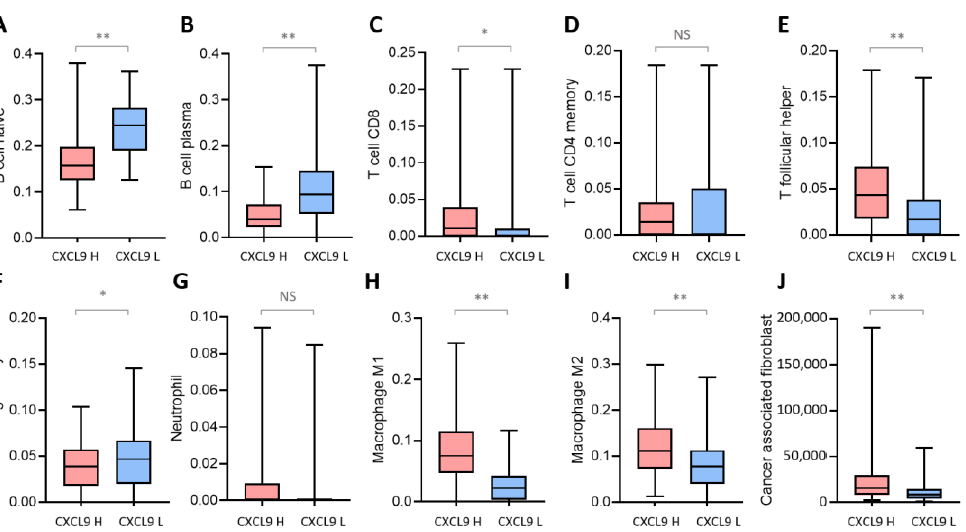
Figure 5. Immune cell infiltrations in CRCs with high and low CXCL9 expression. Immune cells infiltrations, including naïve B cells ( A ), plasma cells ( B ), CD8+ T cells ( C ), CD4+ memory T cells ( D ), T follicular helper cells ( E ), regulatory T cells ( F ), neutrophils ( G ), M1 macrophages ( H ), M2 macrophages ( I ), and cancer associated fibroblasts ( J ), were estimated using TIMER 2.0 and the t - test was used to determine the difference between CRCs with high and low CXCL9 expression. The central line, bottom, and top of the box indicate the median, 25th percentile, and 75th percentiles of the data. ** p < 0.001; * p < 0.05; NS, not significant. 3. Discussion In this study, we analyzed the prognostic impact of PD-L1 expression in patients with stage III and high-risk stage II CRC, and the potential interactions in the tumor immune microenvironment. Our data showed that CPS of ≥5 was associated with better RFS in early-stage CRC patients undergoing the standard surgery and receiving the adjuvant FOLFOX chemotherapy. CRCs with high PD-L1 expression had a higher expression level of CXCL9 . The data from the TCGA PanCancer Atlas showed that IFN-gamma signaling was one of the immune-related gene signatures enriched in CRCs with high PD-L1 expression, and high CXCL9 expression was associated with more CD8+ T cells and M1 macrophages but less regulatory T-cell infiltration.